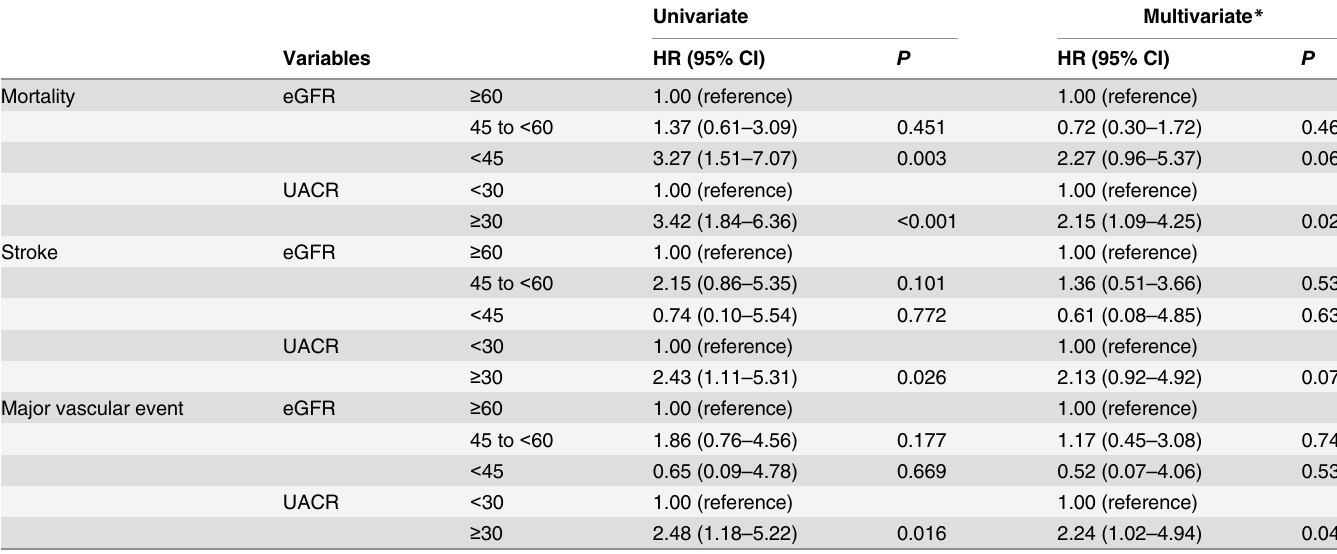
Table 2. Cox proportional hazards models for mortality, stroke, and major vascular events.